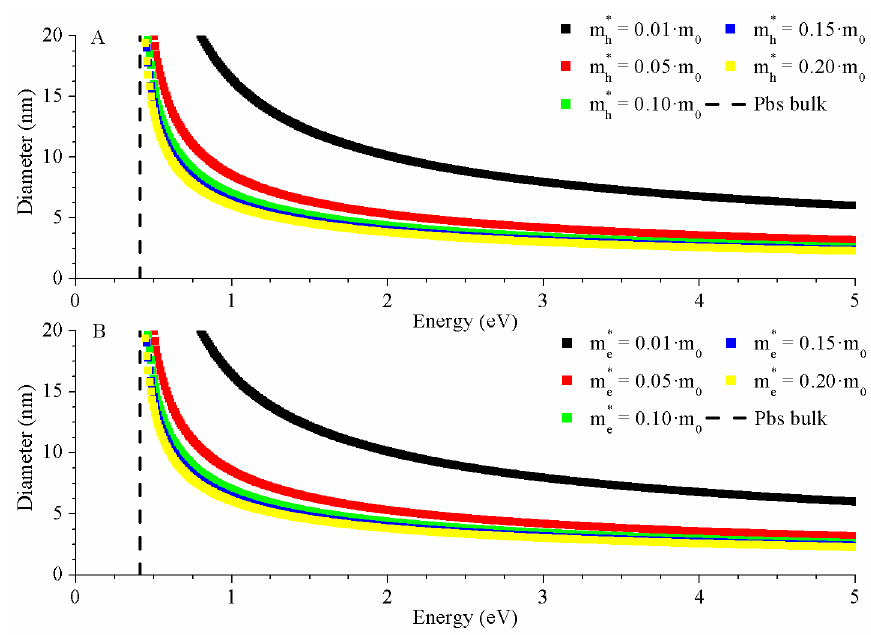
Figure 7. The m h * variation study ( A ) for Brus equation of PbS nanoparticles for di ff erent energies, from high values of energy to PbS energy bulk. The m h * oscillated between m h * = 0.01 · m o and m h * = 0.20 · m o with the rest of the variables remaining constant: E b = 0.41 eV, ε = 17.2, and m e * = 0.085 · m o . The m e * simulation ( B ) for Brus equation of PbS nanoparticles for di ff erent energies, from high values of energy to PbS energy bulk. The m e * oscillated between m e * = 0.01 · m o and m e * = 0.20 · m o and with the rest of the variables remaining constant: E b = 0.41 eV, ε = 17.2, and m h * = 0.085 · m o .